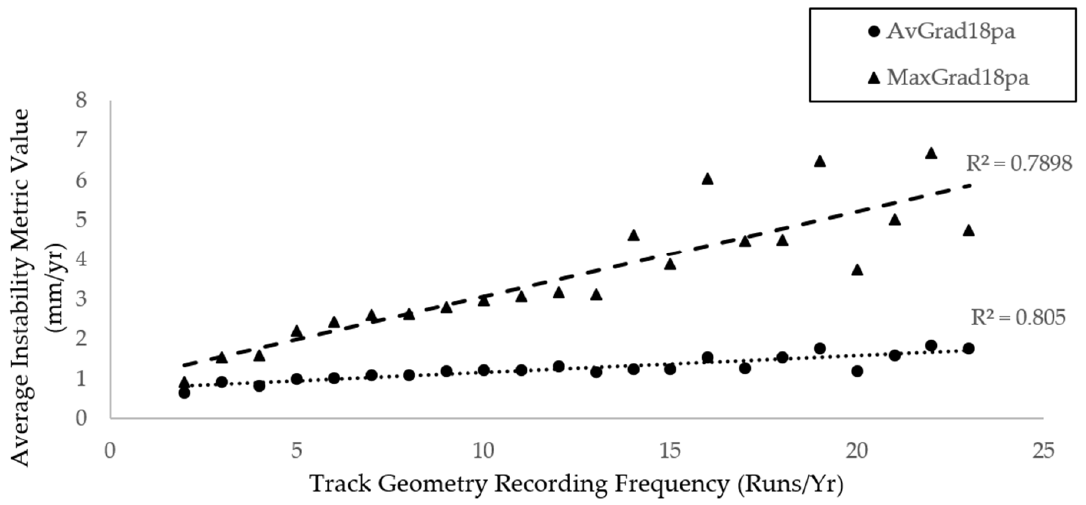
Figure 8. Track geometry recording frequency vs. embankment instability metric.